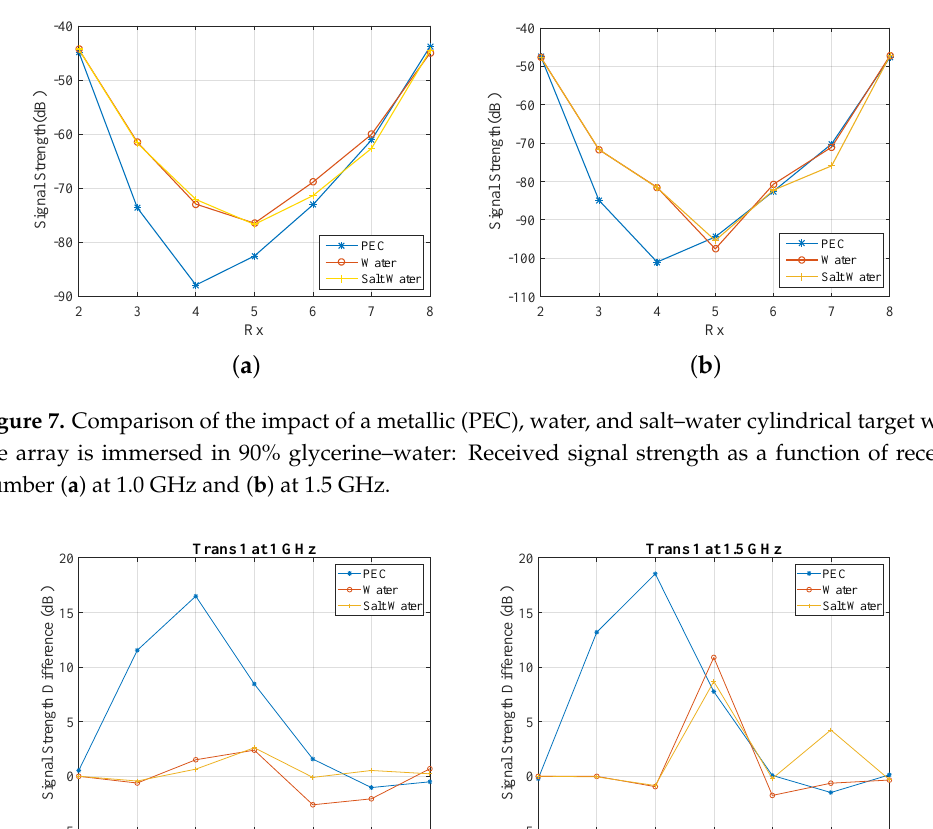
Figure 6. CST-calculated received signal strength as as function of receiver number when the array is immersed in 90% glycerine–water ( a ) without target and ( b ) with metallic (perfect electric conductor, PEC) target.